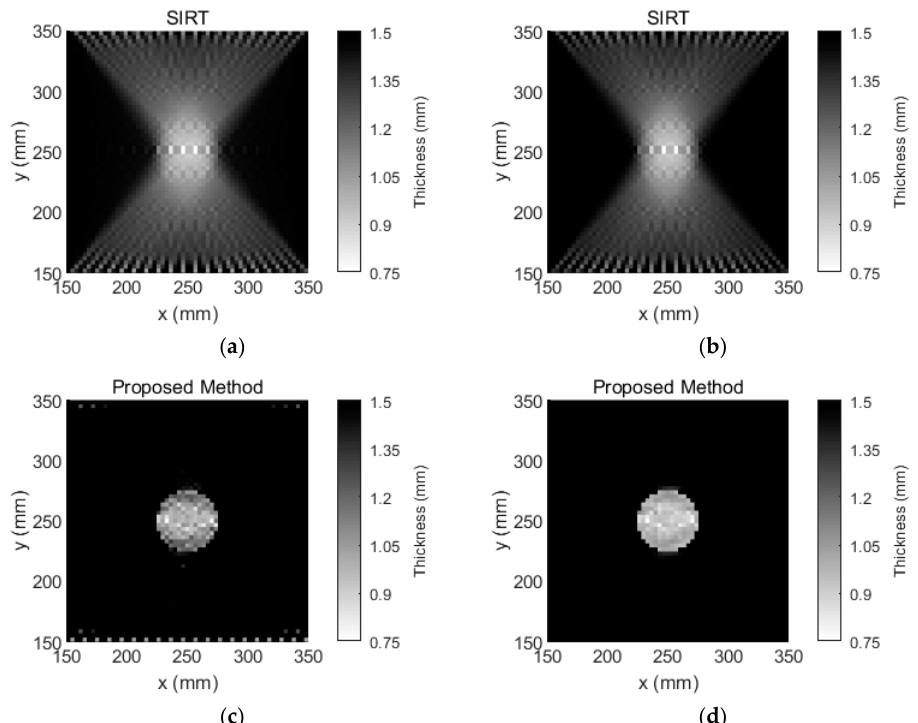
Figure 6. Tomographic reconstruction images for a 1.5-mm-thick aluminum plate with a 50-mm-diameter circular flat-bottomed hole. The thickness loss is 50% within the flaw. ( a ) The tomographic reconstruction image that is obtained via SIRT without temperature compensation, ( b ) the tomographic reconstruction image that is obtained via SIRT with temperature compensation, ( c ) the tomographic reconstruction image that is obtained via our method without temperature compensation, and ( d ) the tomographic reconstruction image that is obtained via our method with temperature compensation.